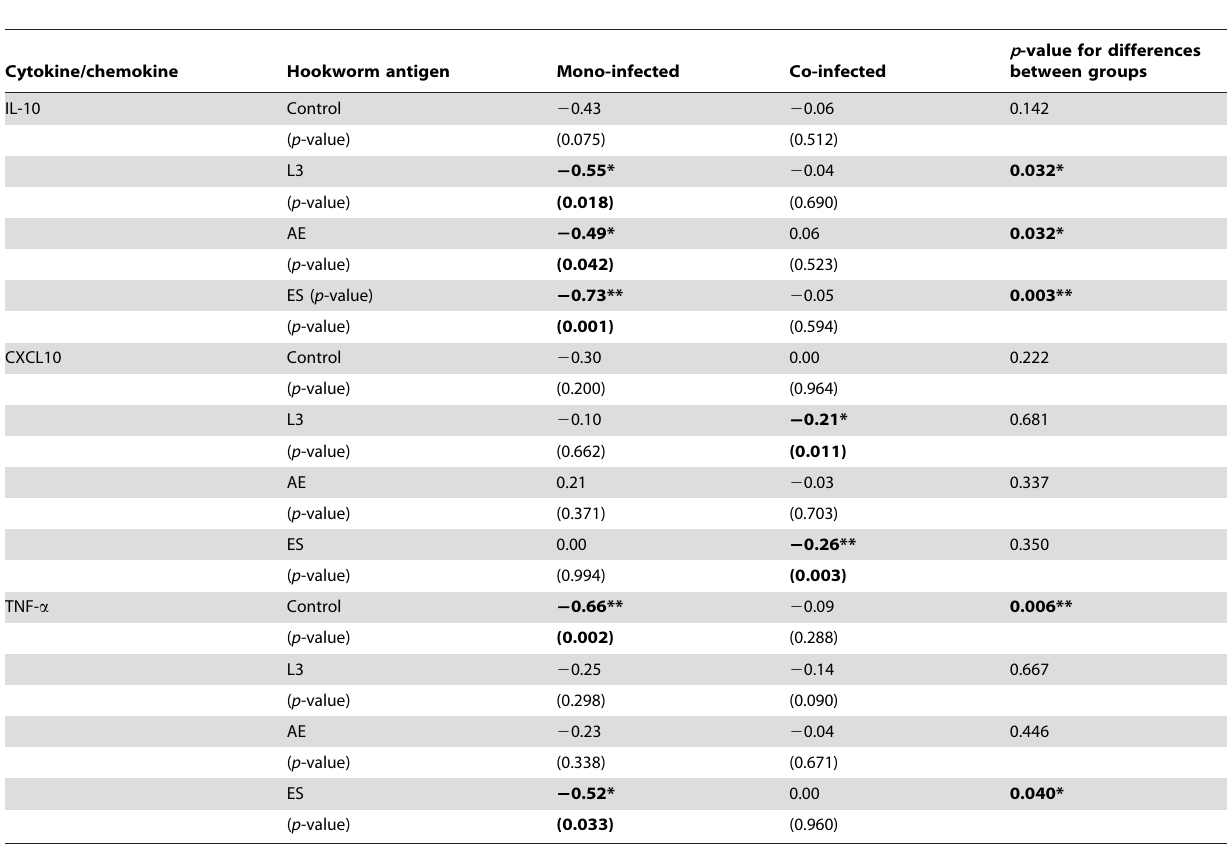
Table 4. Correlations (Spearman’s rank test) between individual hookworm egg counts and antigen-induced cytokine/ chemokine